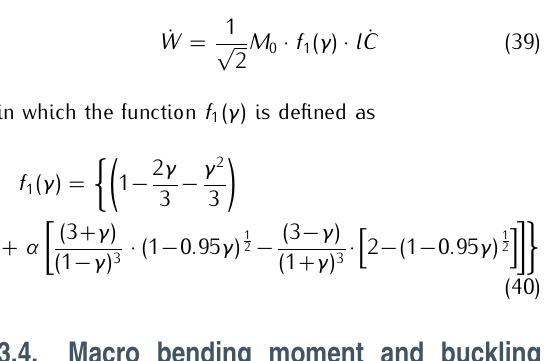
Figure 4. Variations of function f